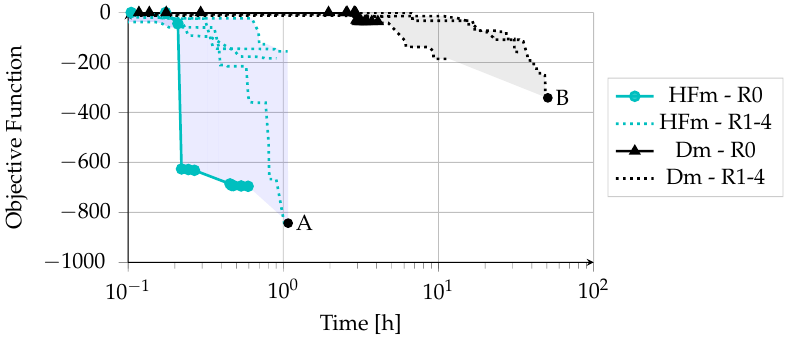
Figure 10. Run time and objective function comparison between the hierarchical framework method (HFm) and the Direct method (Dm). R represents Restart. The objective function is defined in Equation 3. The solid line shows the results when both methods have the same initial conditions which were a single 1 1mm void at the center of each chamber domain. All other optimisations (shown as dotted lines) had random starting points. Best solution values, A = (1.07, 342) and B = (50.65, 342). − Table 3. Breakdown of different optimisation problems in each method.